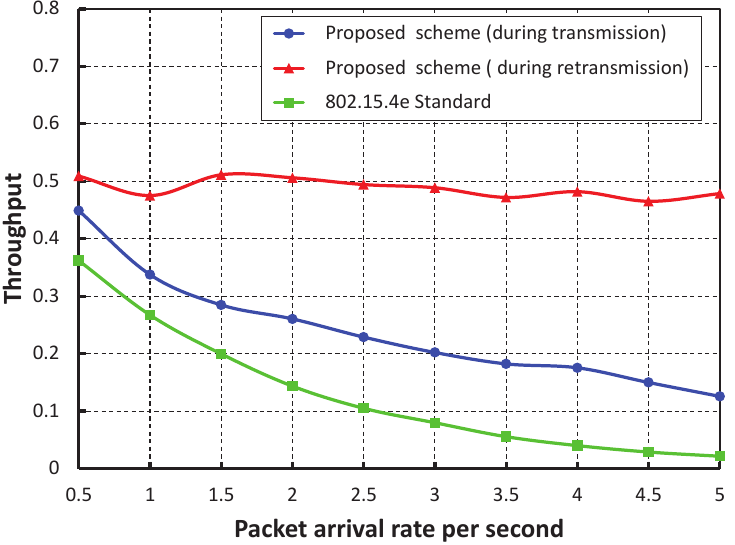
Figure 12. Comparison of the throughput of our proposed scheme with the IEEE 802.15.4e